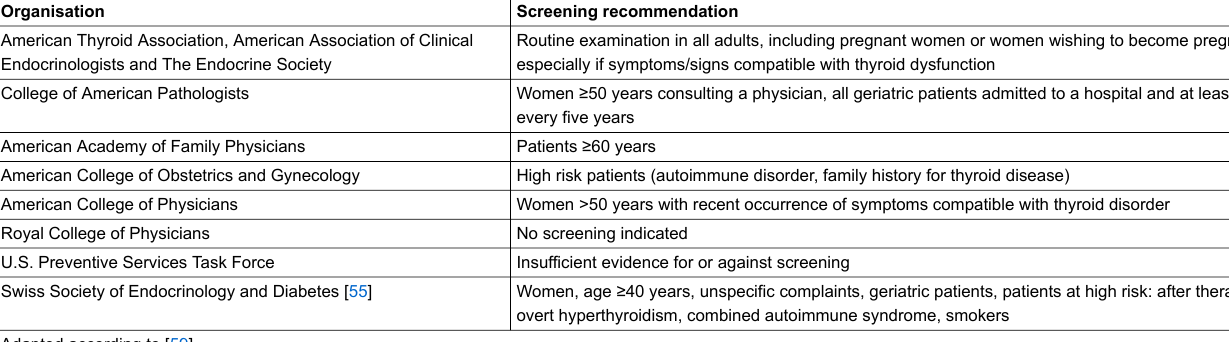
Table 3: Recommendations for screening of subclinical hypothyroidism in asymptomatic adults. Organisation Screening